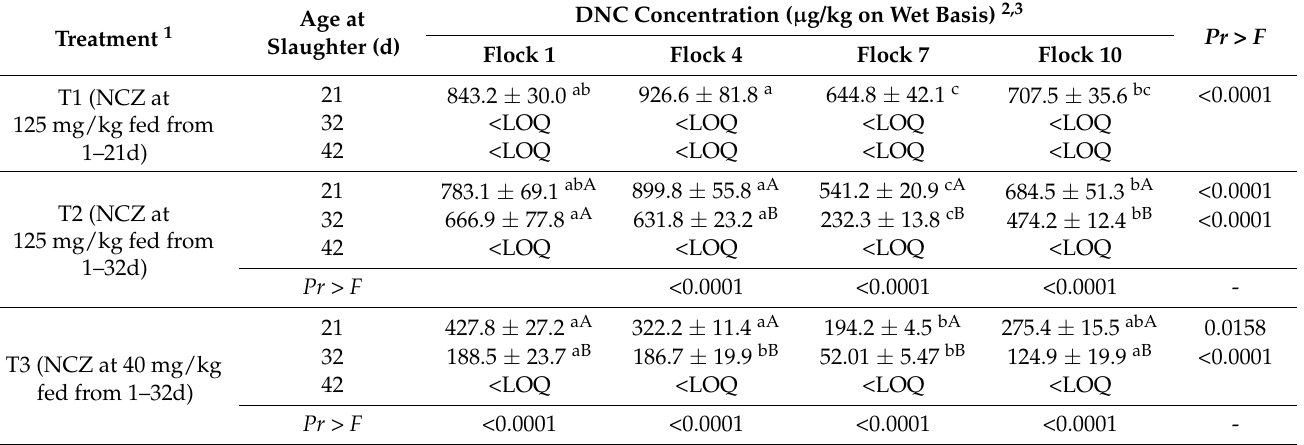
Table 1. DNC concentration in chicken breast fillet from NCZ-fed broilers raised on poultry litter used for multiple flocks.